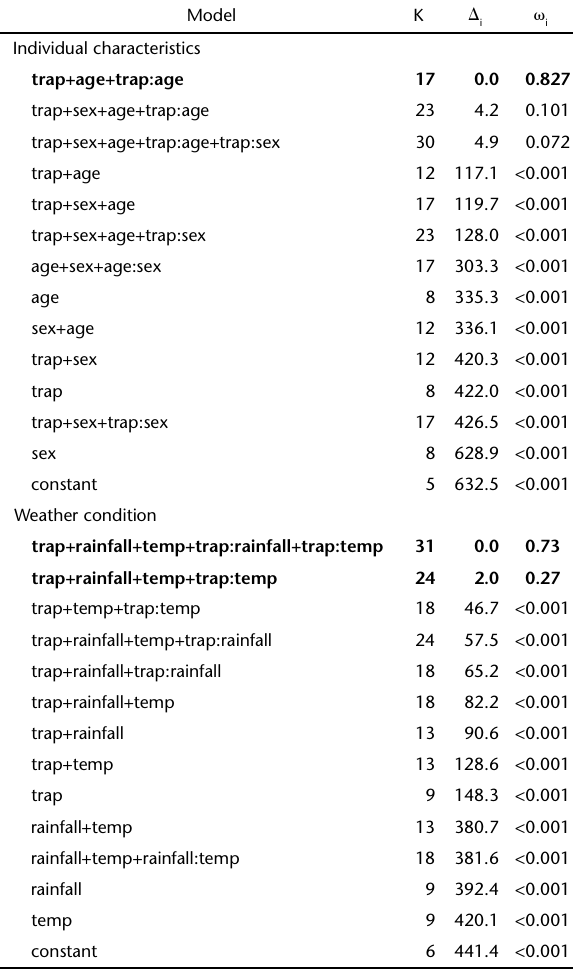
Table 3. Results of model selection for the number of captures of small mammals as a function of the type of trap, individual characteristics (age and sex), and weather condition (rainfall and minimum temperature), considering only captures from Sherman traps placed intercalated with pitfall lines. Check the text for random factors. Selected models